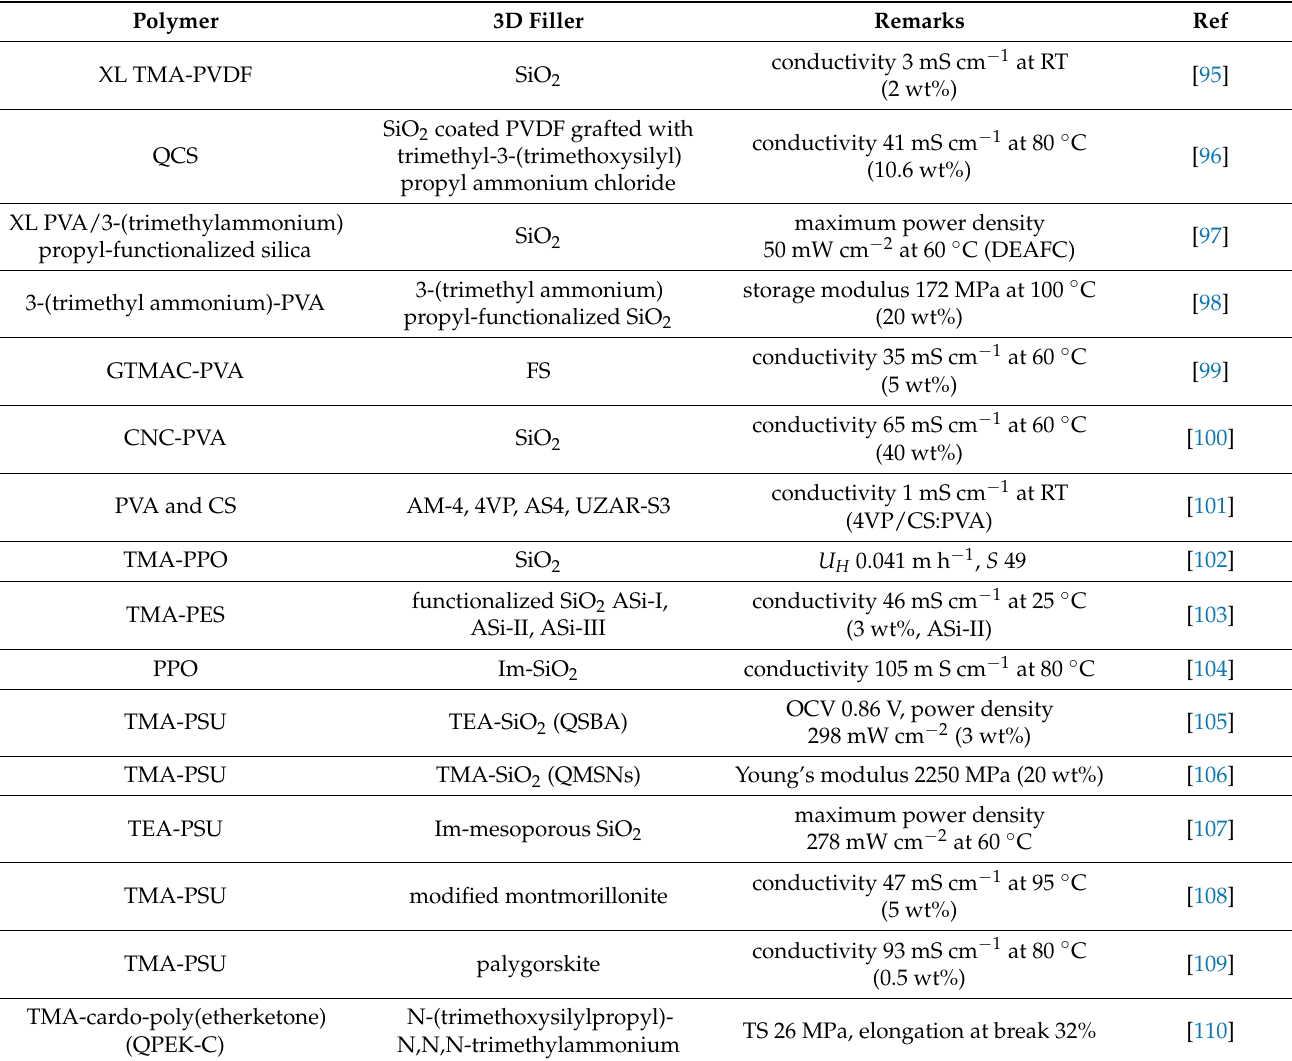
Table 4. Type of polymer and of 3D filler in composite AEM with silica and silicate